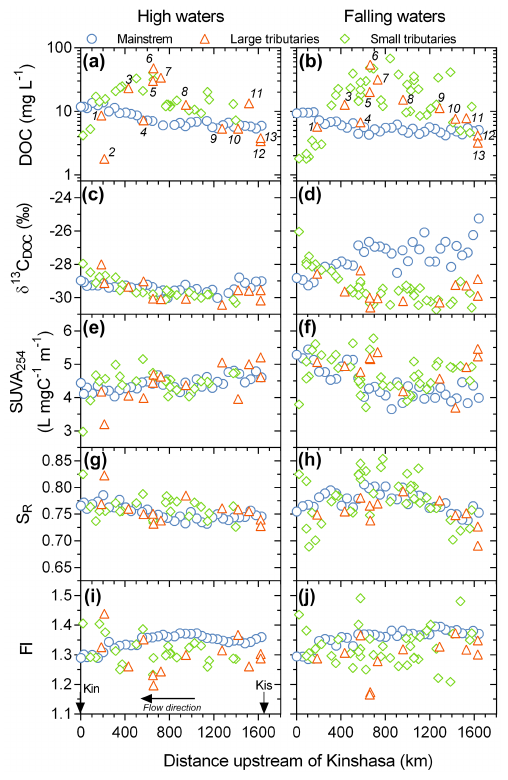
Figure 3. Longitudinal evolution of DOM properties in the main- stem, large and small tributaries along the Kisangani–Kinshasa tran- sect during HW (left panels) and FW (right panels). From top to bottom, the panels represent DOC, δ 13 C DOC , SUVA 254 , S R and FI. Numbers refer to large tributaries: (1) the Kwa/Kasai, (2) the Lefini, (3) the Sangha, (4) the Oubangui, (5) the Ruki, (6) the Ikelemba, (7) the Lulonga, (8) the Mongala, (9) the Itimbiri, (10) the Aruwimi, (11) the Lomami, (12) the Lindi and (13) the